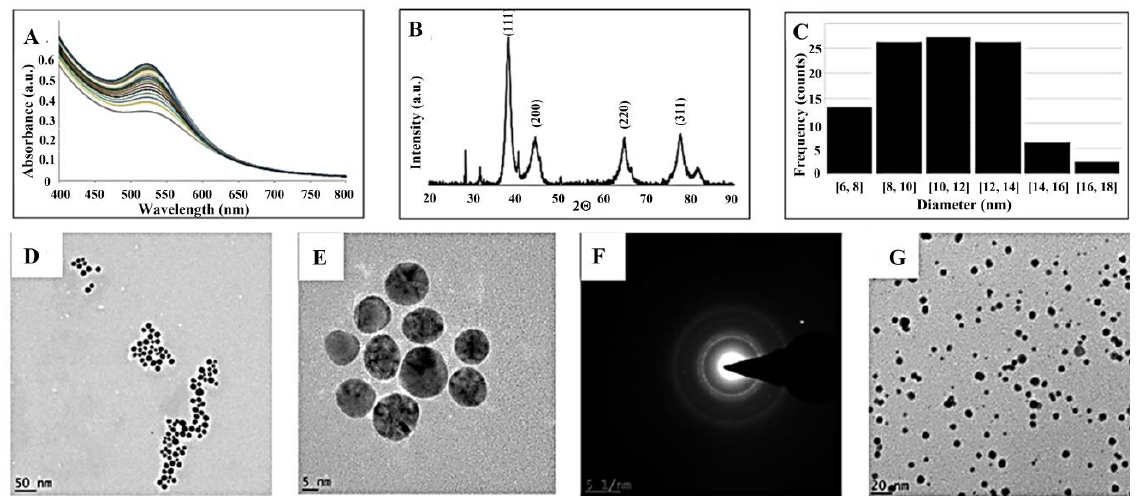
Figure 3. UV/Visible spectra ( A ) collected (in water) every 5 s for 24 h showing the sAuNP formation using SiAE, and the XRD powder pattern ( B ). The sAuNP size distribution ( C ) and TEM images ( D , E ), together with the SAED ( F ) pattern obtained for sAuNPs are also shown. The TEM image obtained